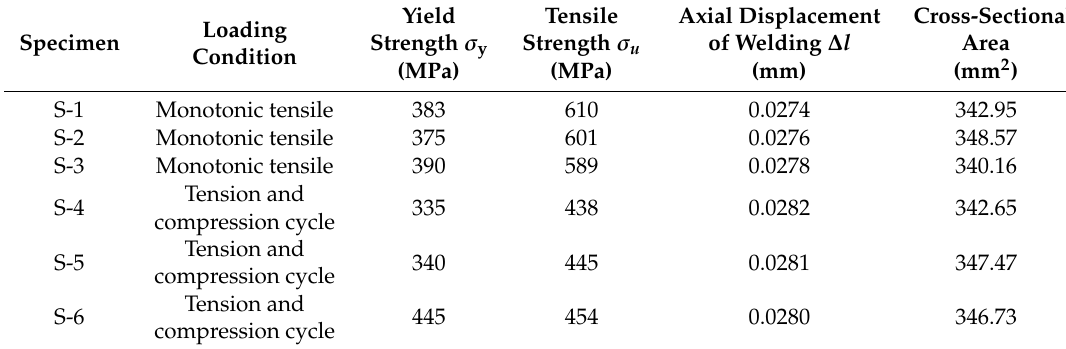
Table 1. Mechanical performance of the welded plate joints.